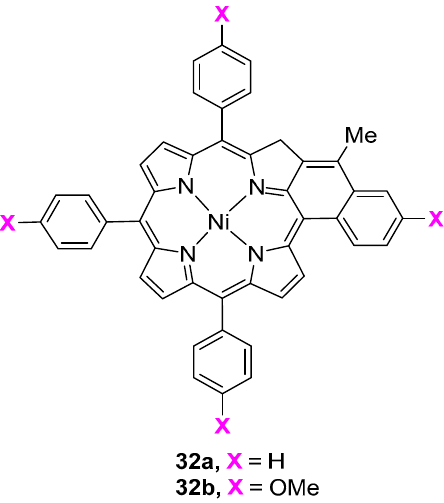
Figure 11. Naphthochlorin derivatives obtained from acid treatment of Ni(II) complex of β - vinylporphyrins 31 [117].